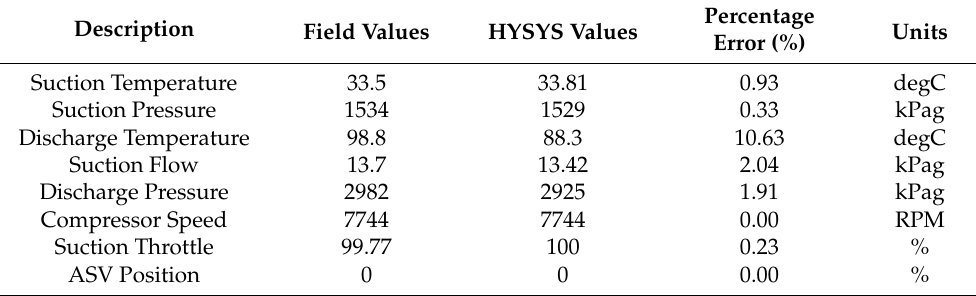
Table 1. A comparison of the CC HYSYS model with practical values.